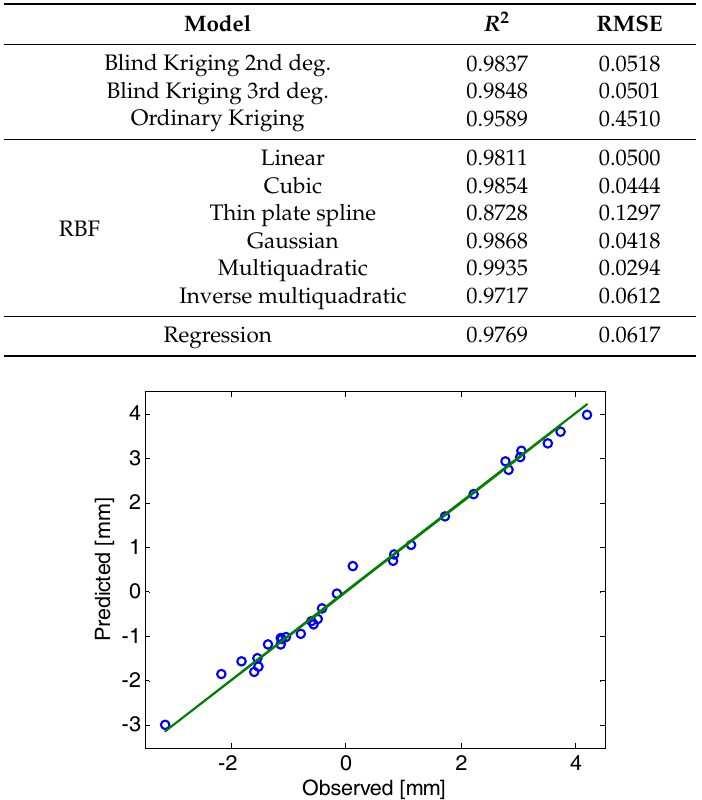
Table 4. Results of model verification for different prediction models.